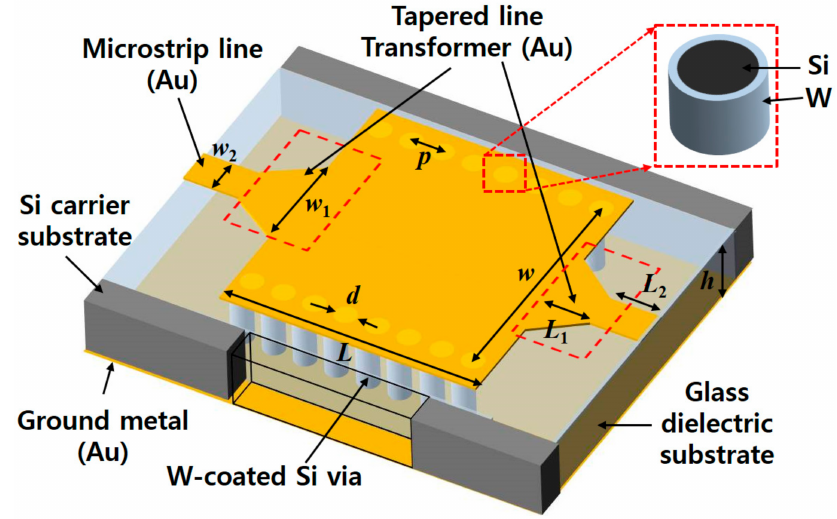
Figure 1. Schematic view of the proposed substrate integrated waveguide (SIW) with tungsten-coated through glass silicon via